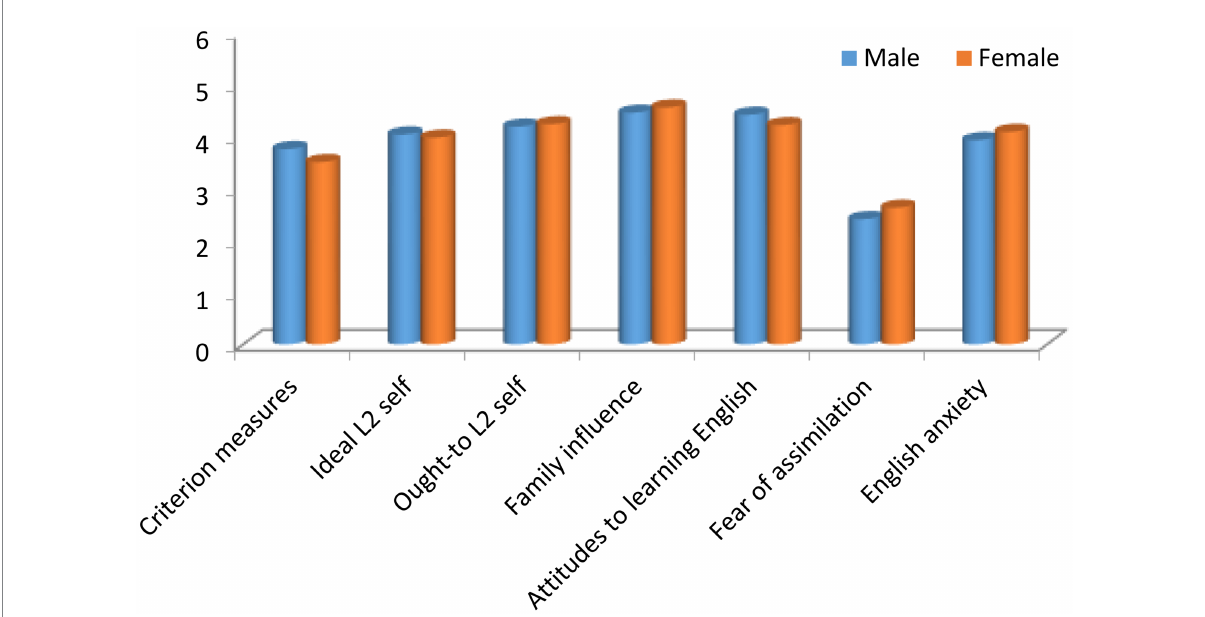
DIAGRAM 2 Comparison of the male and female students’ responses to each of the 7